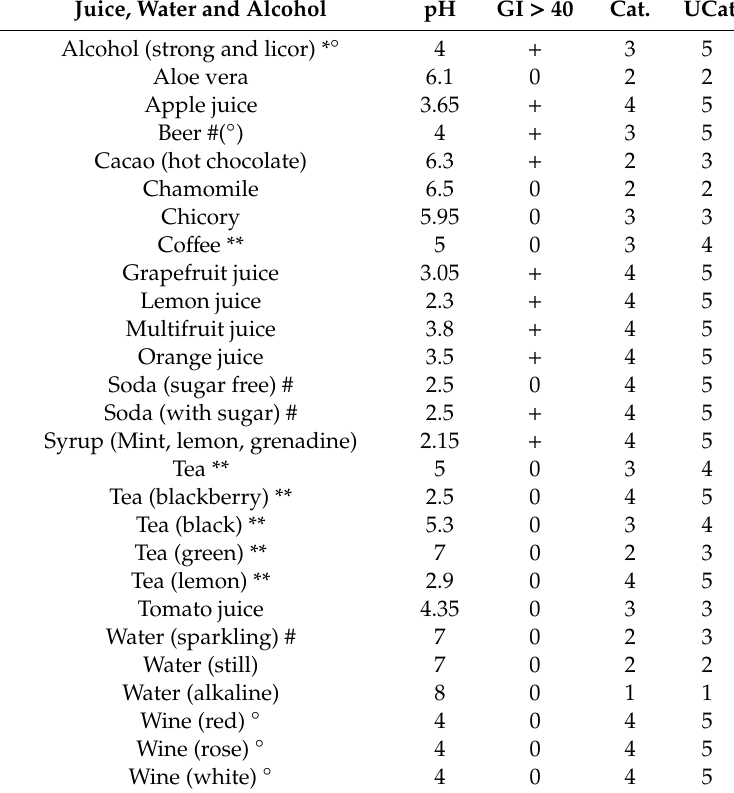
Table 5. The Refluxogenic Diet Score of beverages and their related categories. Juice, Water and